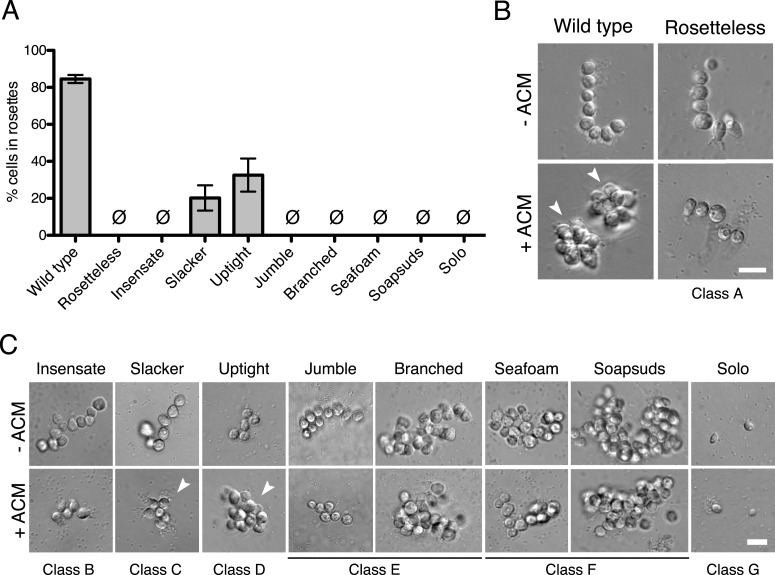
Phenotypes of diverse rosette defect mutants.(A) Cultures of all nine mutants isolated in this study showed a significantly reduced number of cells in rosettes relative to wild type (one-tailed Mann–Whitney test, p < 0.01). Rosette development was measured as the % of cells in rosettes after 48 hr in 20% ACM, shown as mean ± SEM. Ø indicates mutants in which no rosettes were observed (limit of detection = 0.03%). (B) Wild-type S. rosetta grown without ACM formed flexible, linear chains or single cells (Figure 3—figure supplement 2). When exposed to ACM, wild-type S. rosetta cultures produced spherical rosettes (arrowheads). Rosetteless cultures did not form rosettes in ACM, but otherwise appeared in wild type, forming normal chain colonies and proliferating at rates indistinguishable from wild-type S. rosetta (Figures 3—figure supplement 1B,E and 2). (C) Unlike Rosetteless, the remaining eight rosette defect mutants showed additional phenotypic aberrations. Although a small percentage of Slacker and Uptight cells were found in bona fide rosettes (arrowheads), most remained as single cells or chain colonies that were easily disrupted when exposed to shear (Figure 3—figure supplement 1E). Seafoam and Soapsuds formed large, disorganized clusters of cells that were easily disrupted when exposed to shear (Figure 3—figure supplement 1E and 2) and were thus not rosettes. Scale bars = 10 µm.